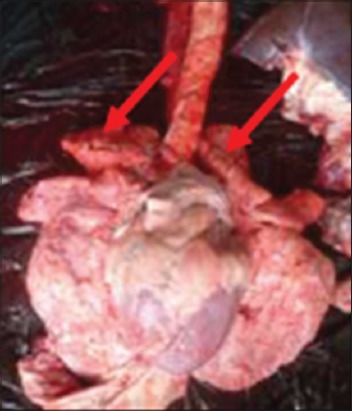
Congested and fibrinous cranial lobes.